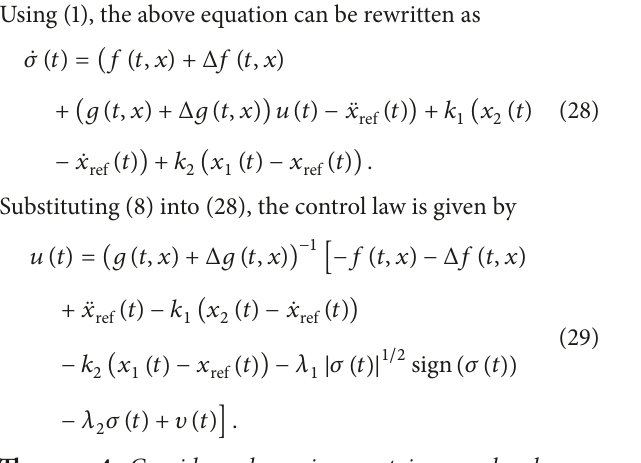
Figure 2: Pendulum system.